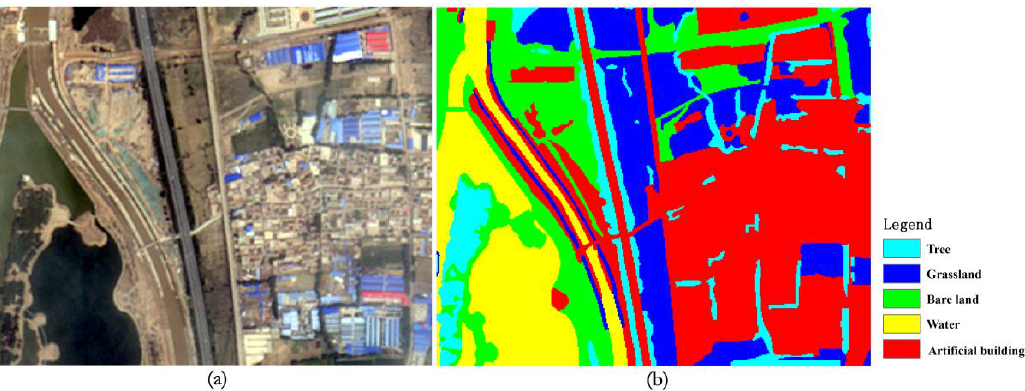
Figure 6. Beijing2 image: ( a ) true color original Beijing2 image and ( b ) ground truth reference image.